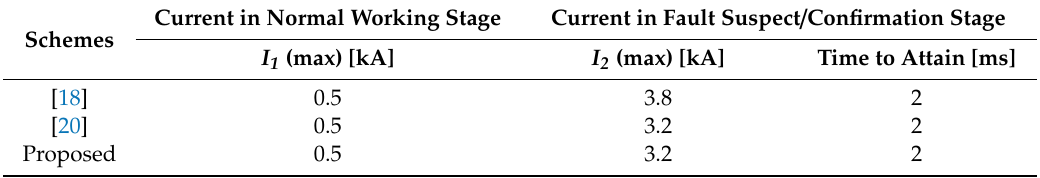
Table 2. Performance evaluation chart for normal and fault suspect / confirmation stage.